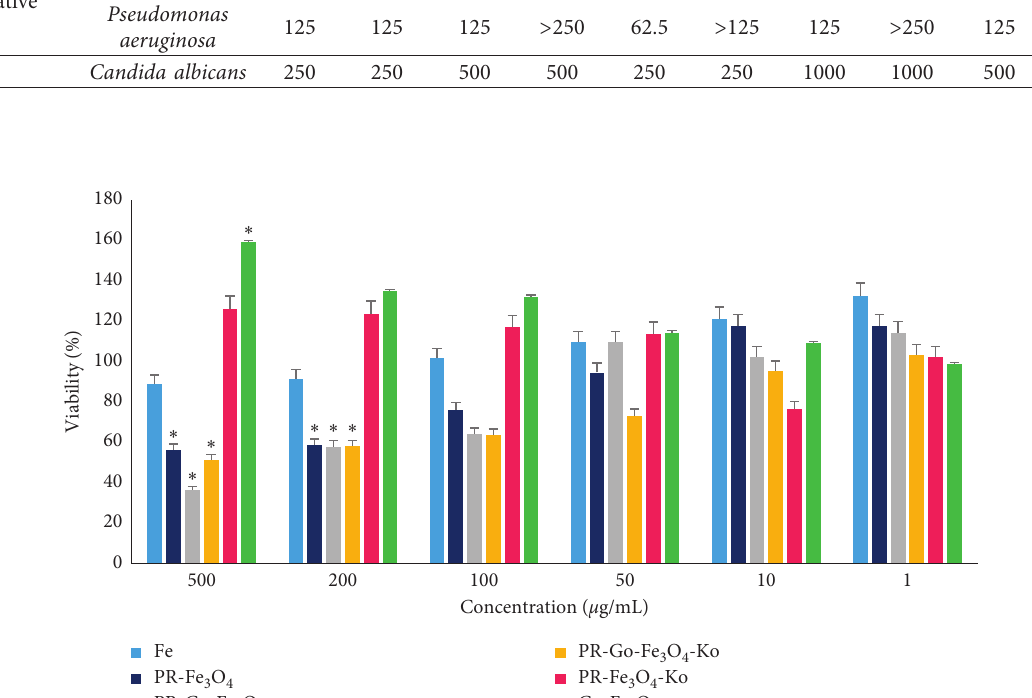
Figure 6: Effect of compounds on cell viability of MTT assay for all tested concentrations on Hep-G2 cells after 24h in comparison with control (untreated cell). Each bar represents the mean ± SD (standard deviation) of three independent tests.